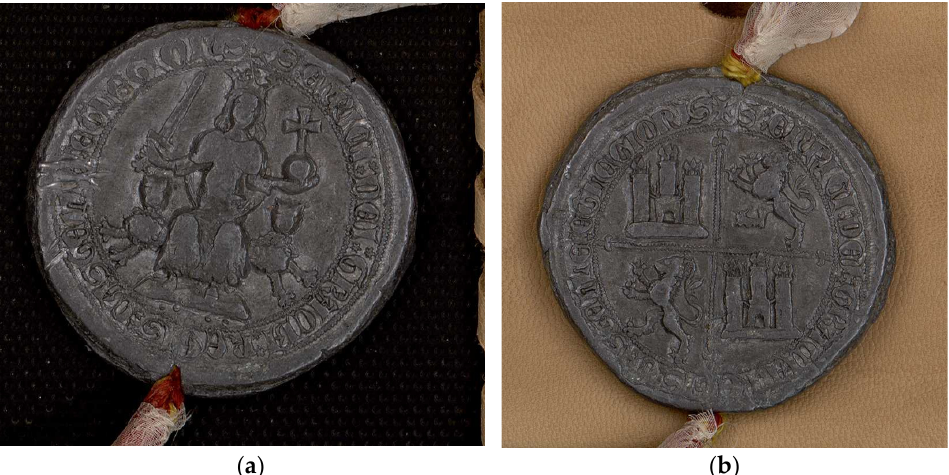
Figure 3. Seal of Henry II. Impression on lead. 1371. Archivo Municipal de Toledo. © Archivo